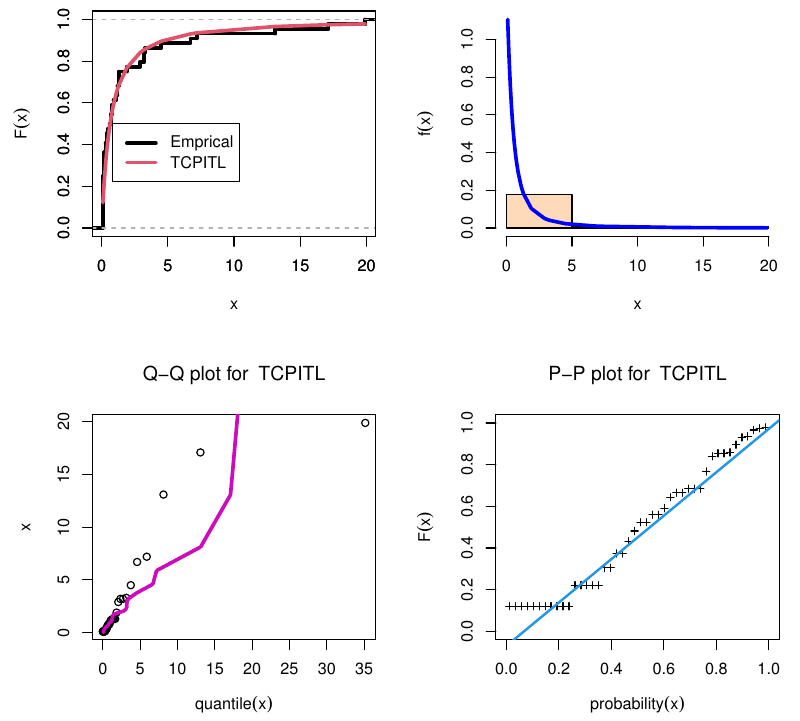
Figure 7. Fitted PDF for Global Reserves Natural data set I.